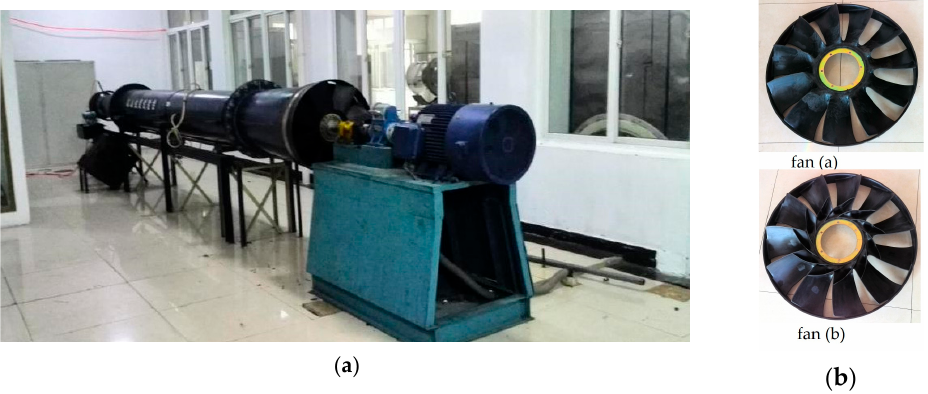
Figure 4. An actual picture of the test bench and tested fans. ( a ) Experimental device; ( b ) two different tested fans.